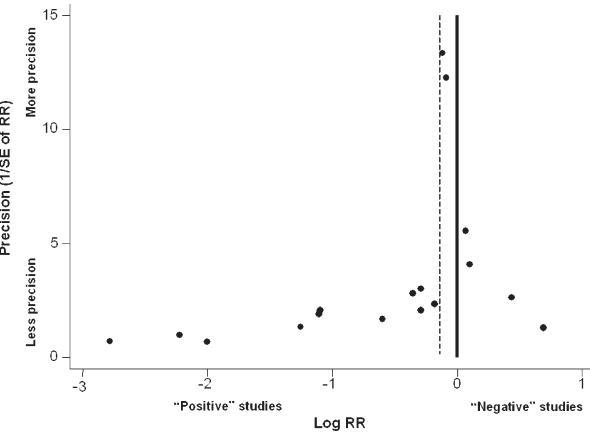
Figure 1 - Funnel plot of 17 studies investigating the effect of low-dose aspirin for preeclampsia prevention (high-risk women) previously analyzed by Ruano et al. 1 Vertical axis depicts the precision represented here by the inverse of the standard error (SE) of relative risk (RR). Horizontal axis represents the logarithm of RR. Solid line denotes null effect and dotted line is the pooled RR under a fixed-effects model (Mantel-Haenszel method). “Positive” studies denote trials showing a protective effect of aspirin in the prevention of preeclampsia (high-risk women), but not necessarily reflecting “statistically significant” studies. “Negative” studies represent trials showing no beneficial effects of aspirin in preeclampsia (high-risk women). Visual inspection of the funnel plot suggests asymmetry. At the bottom right: are small trials showing no beneficial effects